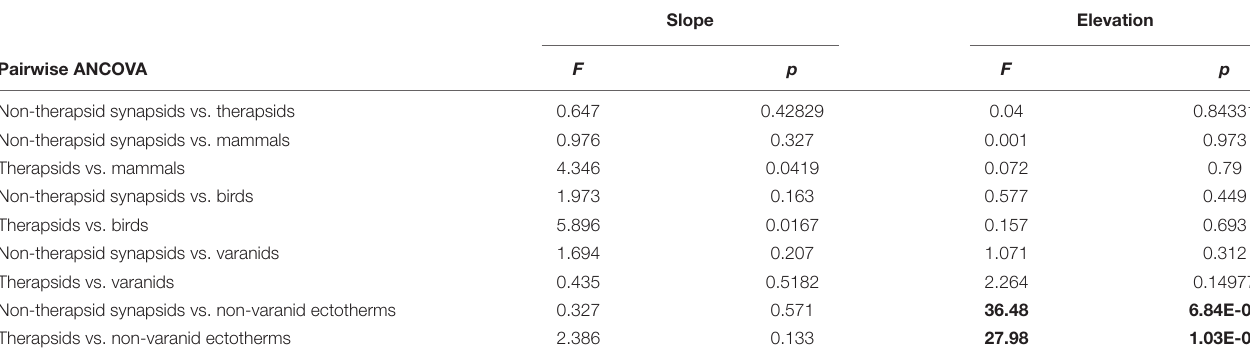
TABLE 3 | Differences in slope and intercept in regression models of Q i vs. body mass between fossil synapsid taxa and recent amniote groups and their statistical significance. Slope Elevation Pairwise ANCOVA F p F